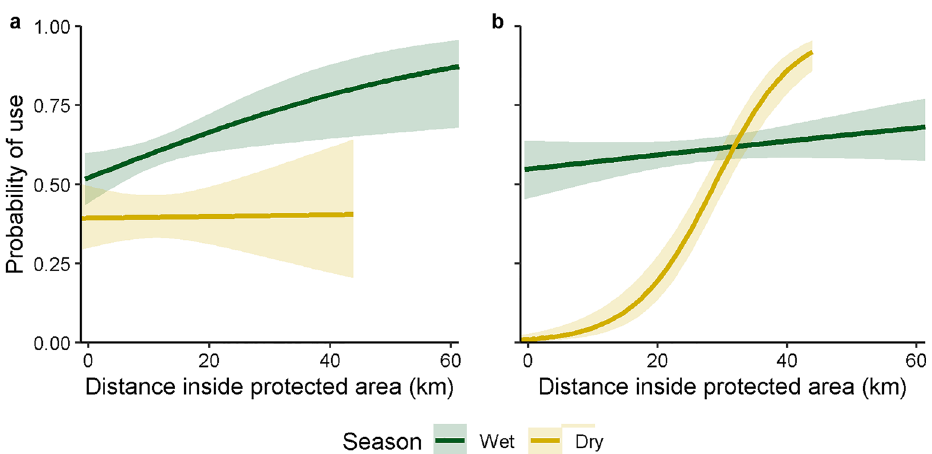
Figure 3. Lion probability of use and 95% confidence intervals relative to distance from edge of the protected area complex (km) in northern ( a ) and southern ( b ) study areas during wet (November–May) and dry (June– October) seasons, holding other continuous variables constant at mean values and using categorical variables of female sex, core protection, and cultivated land, Serengeti ecosystem, Tanzania,